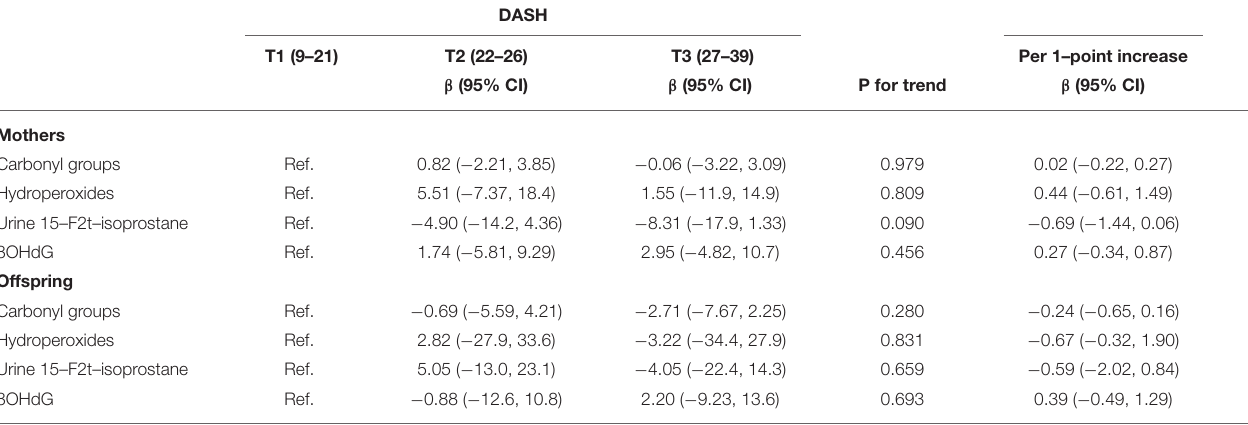
TABLE 4 | Associations between maternal Dietary Approach to Stop Hypertension (DASH) index in the pregnancy and biomarkers of oxidative stress in mothers and their offspring. The NELA study. DASH